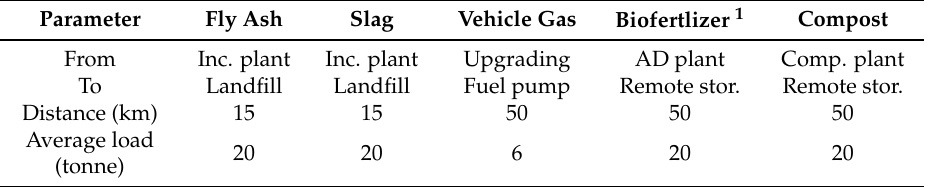
Table A8. Transport data. All transportation is done with truck and trailer with max load 35 tonnes. All transports are empty on return with fuel consumption of 0.5 L/km when full and 0.35 L/km when empty. AD: anaerobic digestion; Inc.: Incineration; and stor: